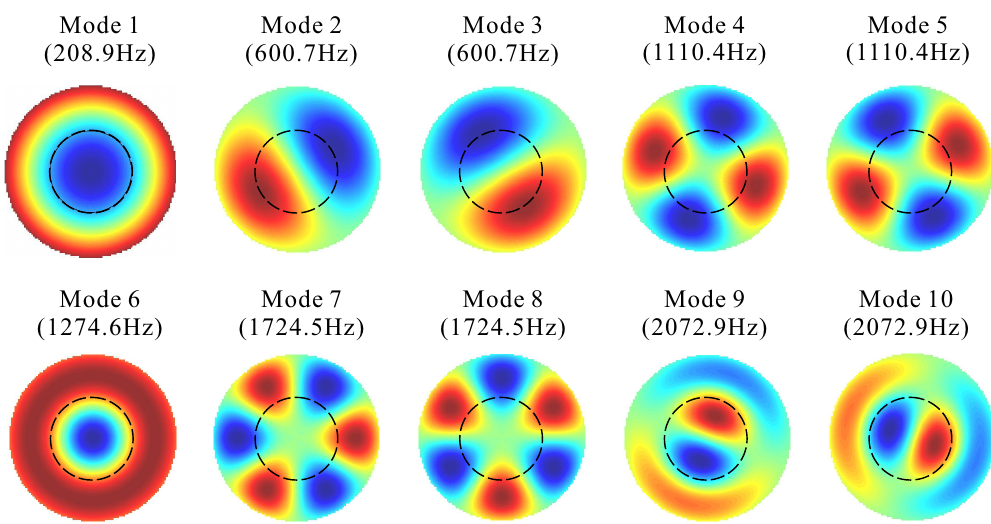
Figure 9. Vibration mode shapes and natural frequencies of the AO mirror. The pupil is represented in dashed lines. Notice the possible confusion between mode 1 and mode 6 within the pupil, and similarly between modes 2–3 and 9–10.